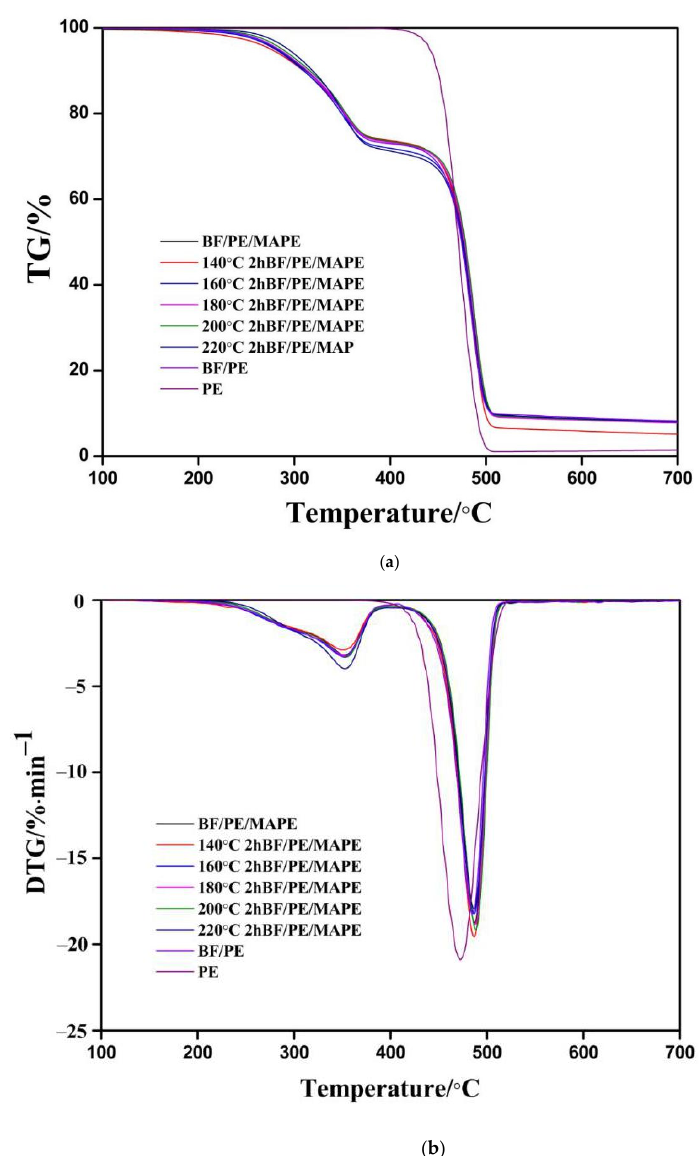
Figure 7. TG ( a ) and DTG ( b ) curves of bamboo plastic composite. Table 6. Decomposition characteristic parameters of PE and bamboo fiber/PE composites.